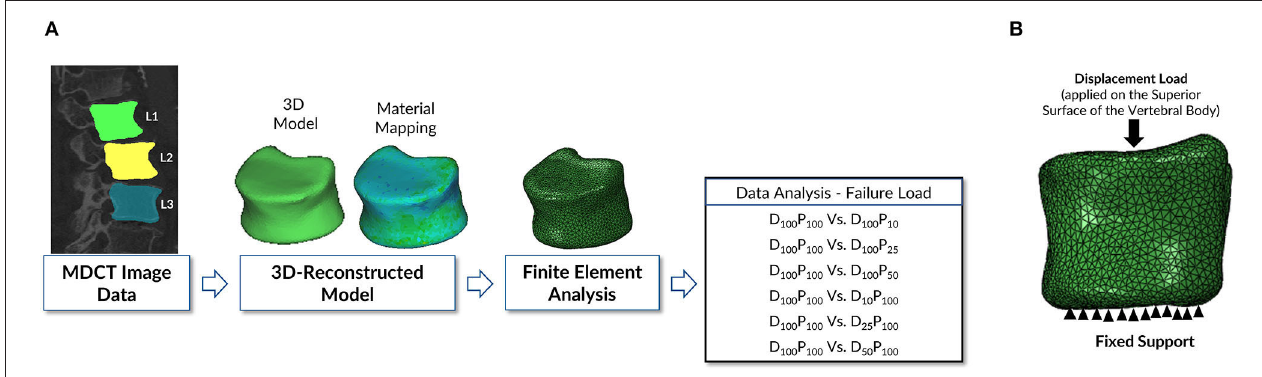
FIGURE 1 | (A) Schematic representation of the finite element modeling and analysis methodology followed in this study. The vertebrae were delineated on the images acquired to generate a 3-D model of the geometry to be used in the downstream finite element analysis protocol to predict bone strength. (B) Loading and boundary conditions applied in performing the finite element analysis of vertebra. Fixed support represents the zero displacement in all directions at the inferior surface of the vertebral body. Displacement load was applied on the superior surface of the vertebral body to predict the failure load.